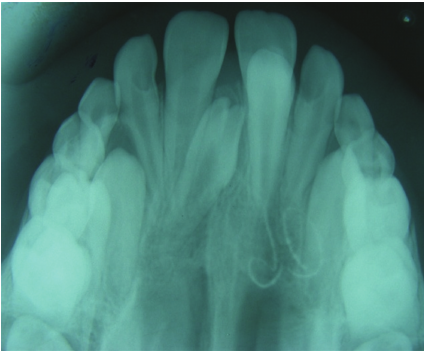
Figure 1: Radiographic appearance of an erupted supplemental 21 along with an unerupted tuberculate supernumerary tooth in maxillary central incisor region.